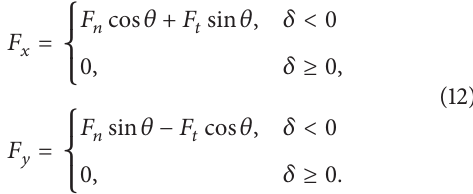
Only 𝑊(𝜉, 𝜂) is an unknown parameter in (10) and (11), and the solution can be solved by means of nonlinear equations or numerical